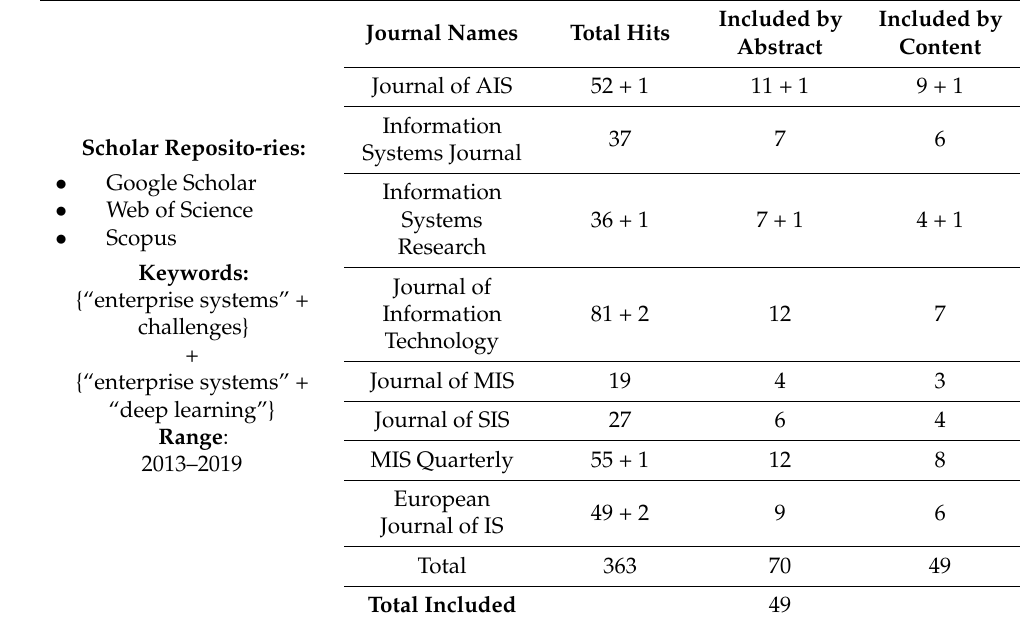
Table 4. Combined returned search hit counts with keyword {“enterprise systems” + challenges} and {“enterprise systems” + “deep learning”} between 2015 and 2020 for the eight basket journal outlets queried on Google Scholar, Web of Science, and Scopus.